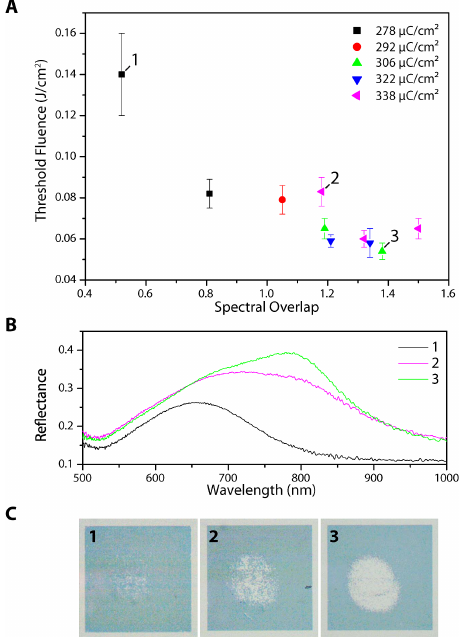
Figure 13: LID thresholds of a number of bow-tie arrays, plotted against their overlap in resonance to the used 800nm laser. a , Ad- ditionally classified by the dominant design parameter ( e − -beam dose, cf. Fig. 12), there is a significant trend that antennas with a “better” resonance are more susceptible to LID. b , We illustrate the difference in quality of the resonance by comparing particular resonance curves of three distinct data points marked in a . c , The quantitative finding from a is exemplified by looking at three dam- age sites, one from each of the numbered types, each exposed to approximately the same pulse energy of ∼ 230nJ